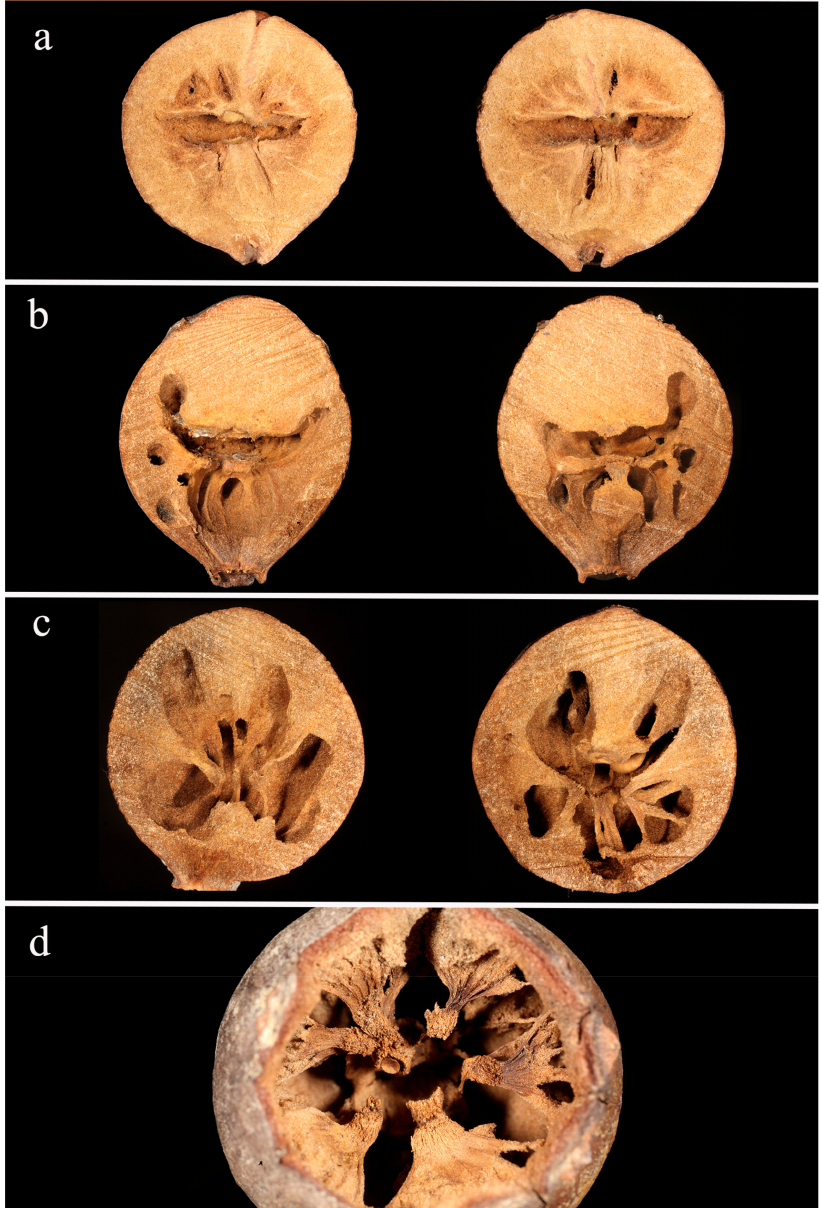
Figure 4. Inner architecture of a gall, when the gall is empty ( a ), colonized by Co. truncata ( b ) or by Temnothorax spp. ( c , d ). Images a, b, c show the two halves of the gall (see text for details). In image d, the gall is seen from above and the upper part has been